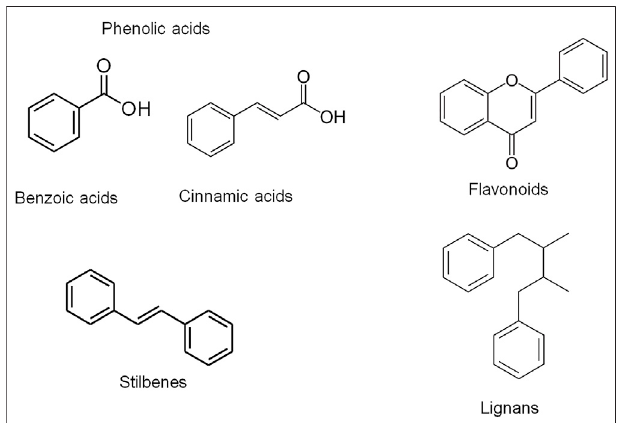
FIGURE 1 | Chemical structures of the different classes of phenolic compounds including phenolic acids, fl avonoids, stilbenes and lignans. Phenolic compounds are classi fi ed into different groups on the basis of the number of phenolic rings they contain and of the structural elements binding the rings to one another. They are generally divided into four classes including phenolic acids, fl avonoids, stilbenes and lignans. Phenolic acids